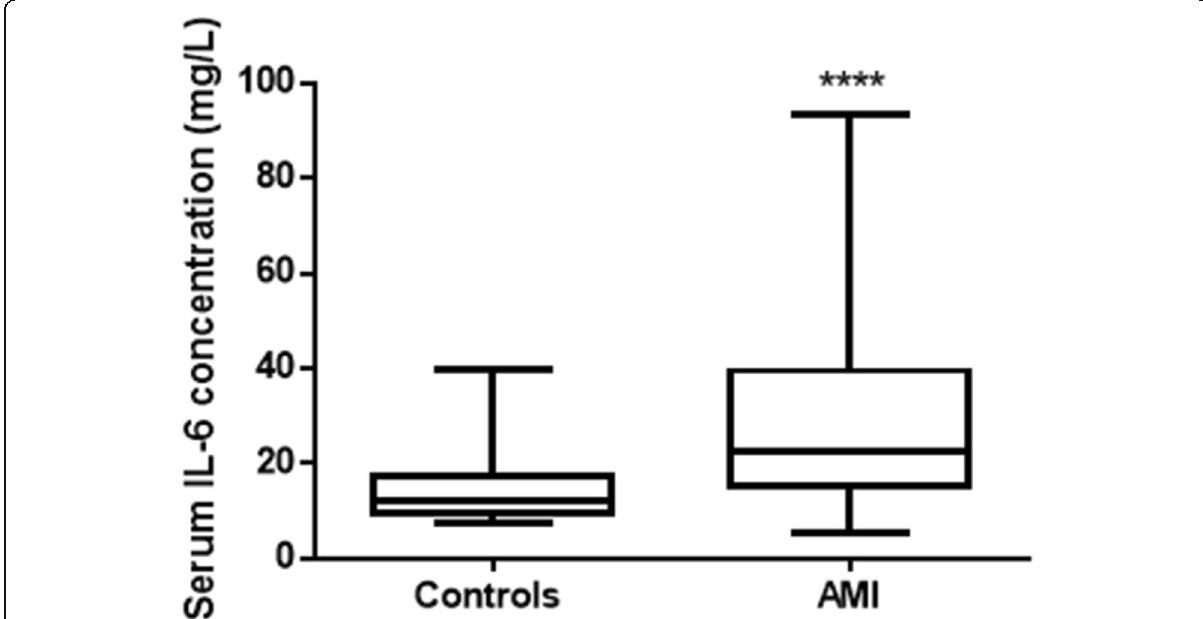
Fig. 2 Boxplots showing serum median and interquartile levels (25th and 75th) of IL-6 concentration in control subjects and AMI. ***Significantly different at P < 0.0001 (Mann-Whitney